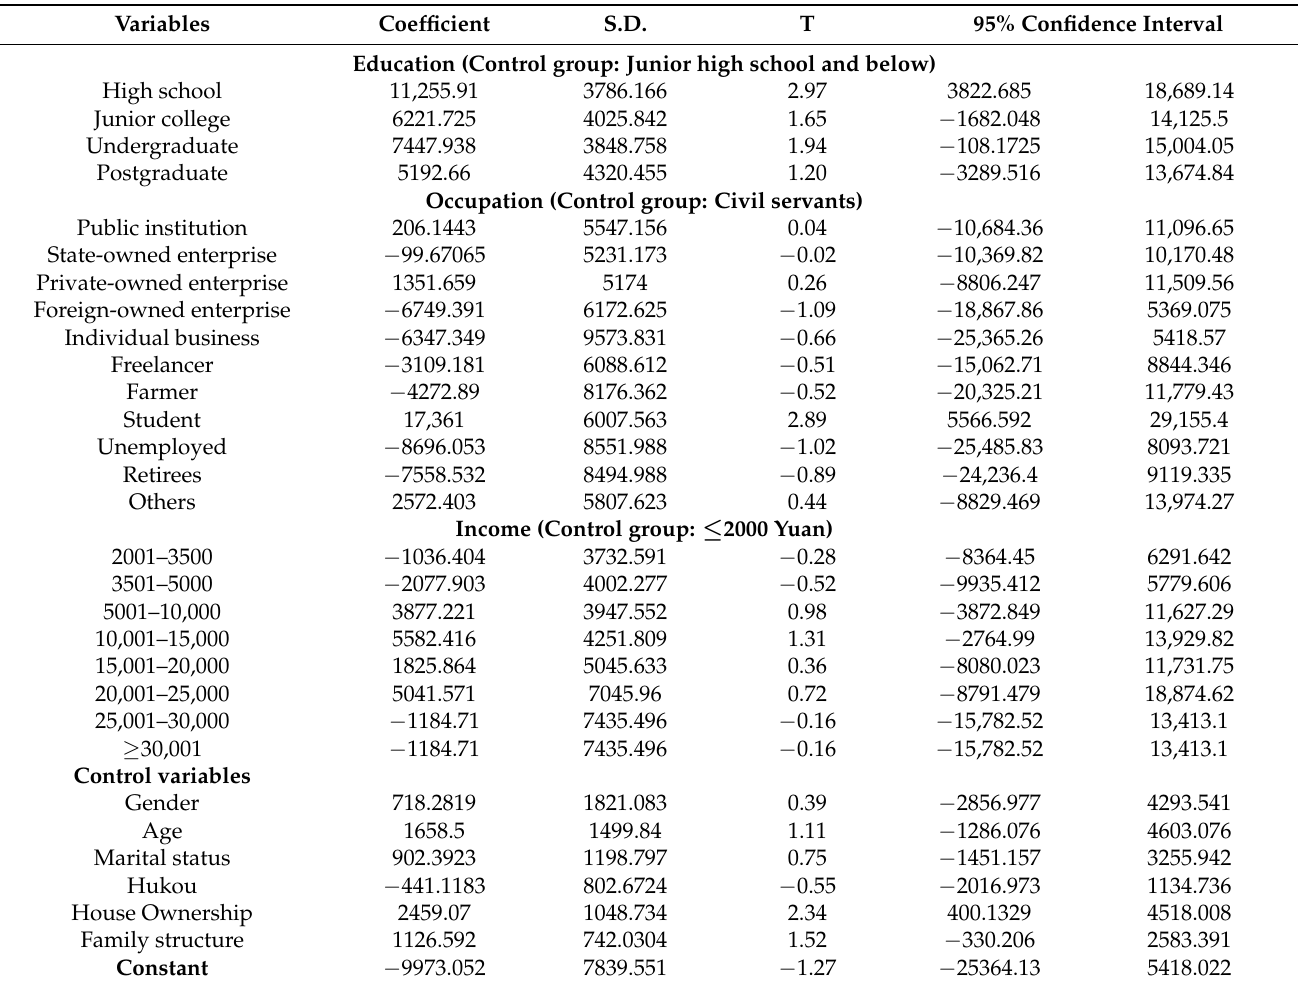
Table A6. Regression results of influencing factor